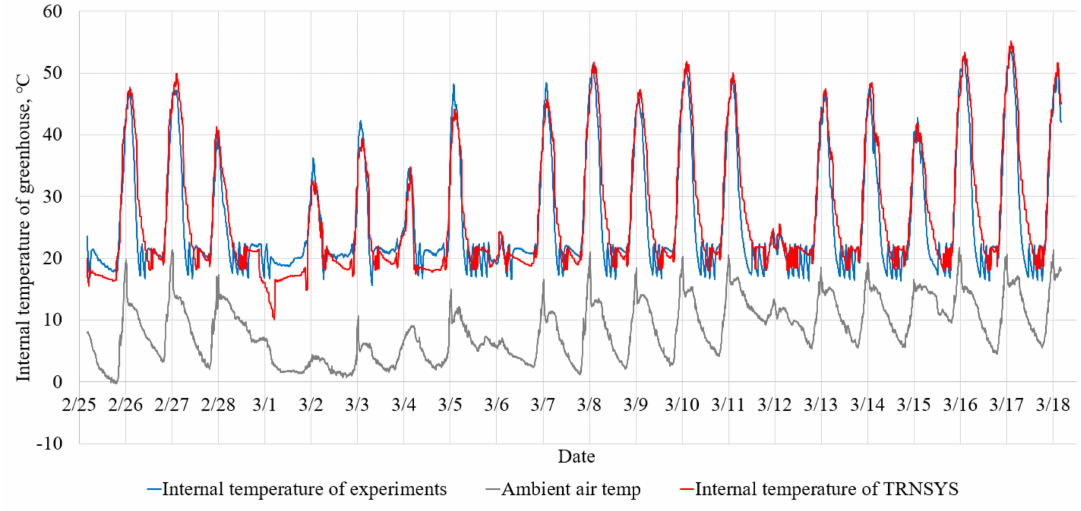
Figure 10. Comparison of results between experiment and